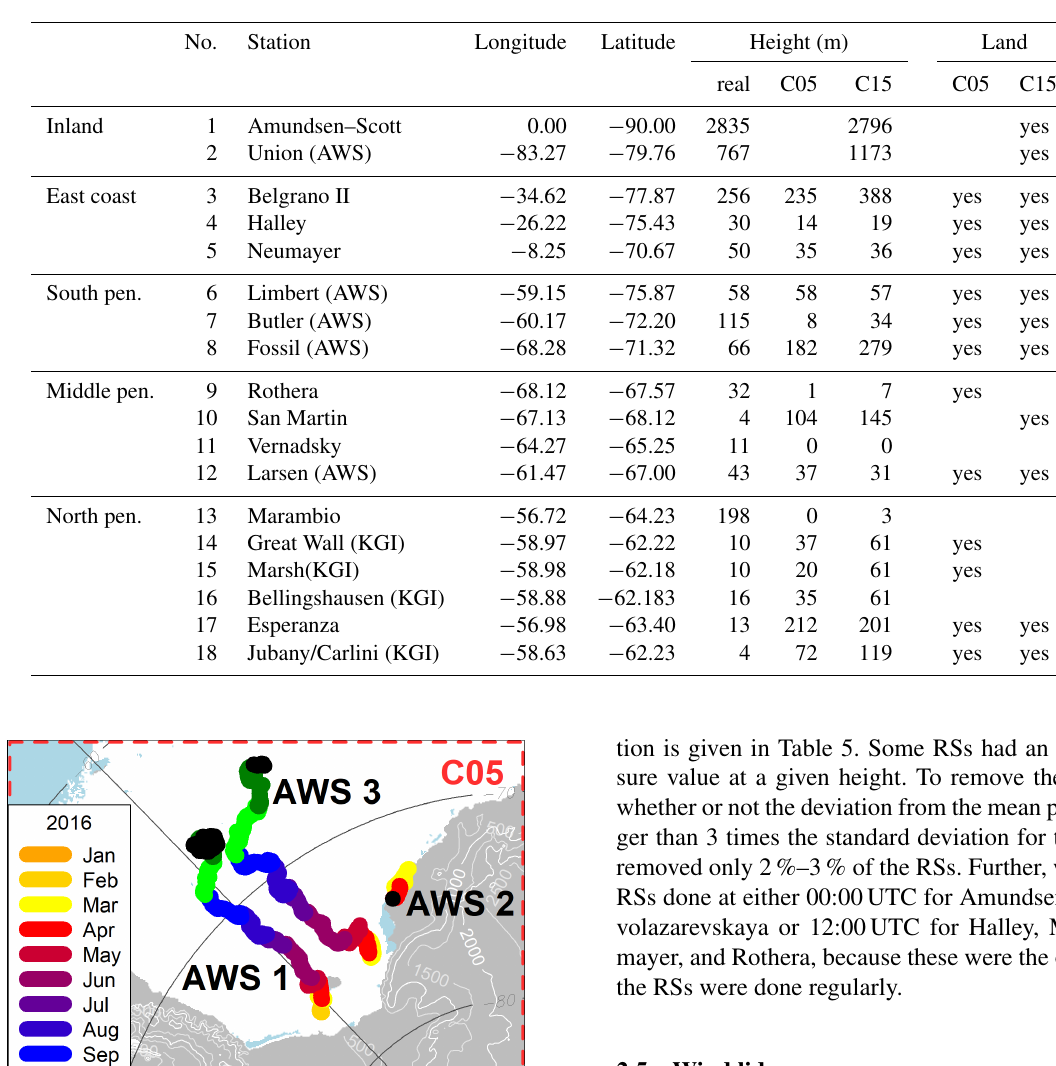
Table 4. Information on the surface stations. The label “yes” over land indicates that the surface type of the compared model grid point is land and not water. Years give the approximate data record length in years. AWS: automatic weather station; KGI: on King George Island.